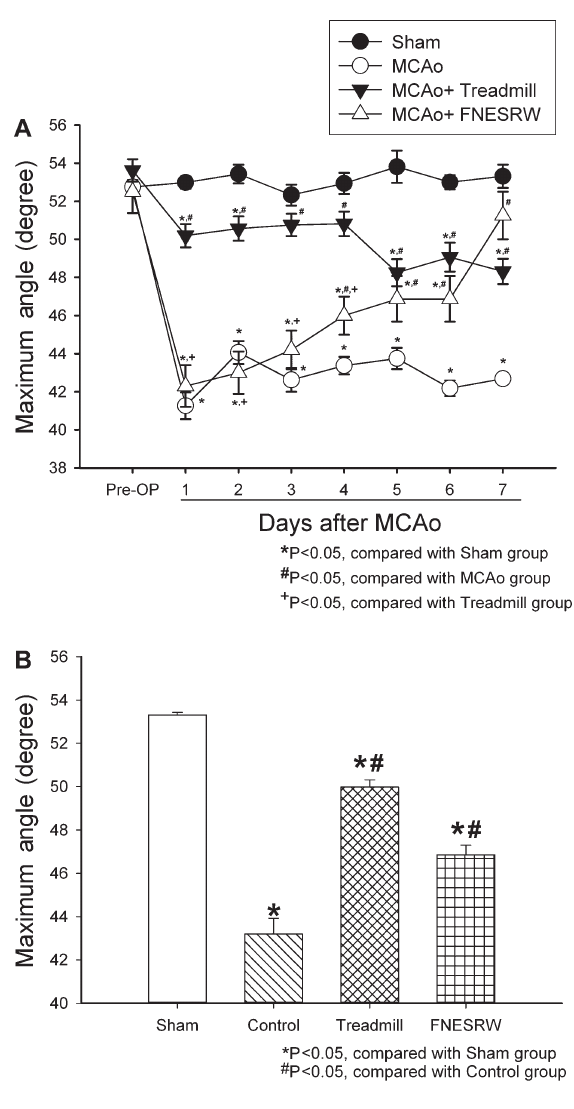
Figure 8. Average angle of the lower limb grip test over a period of 7 days. A , Average daily inclined plane angle. B , Average 7- day inclined plane angle. Data are reported as means±SD. FNESRW: forced non-electric-shock running wheel; MCAo: middle cerebral artery occlusion. Analysis of variance showed a significant difference (P , 0.05), with an F-value of 25.315 for 3 and 32 degrees of